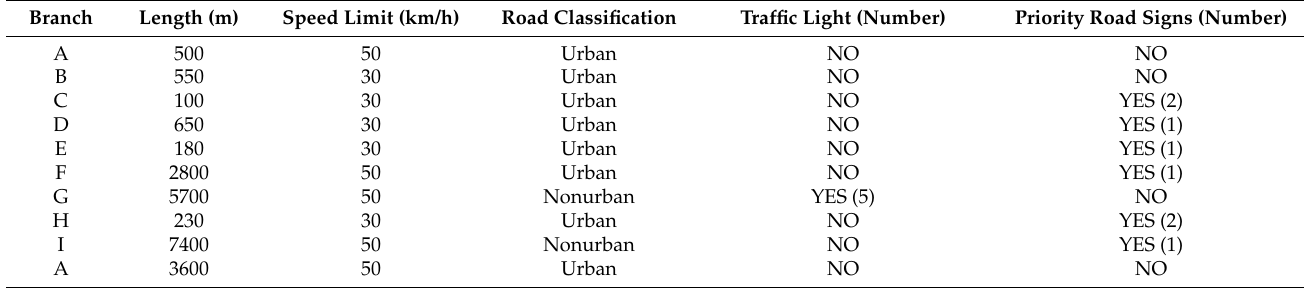
Table 5. Characteristics of the roads for system